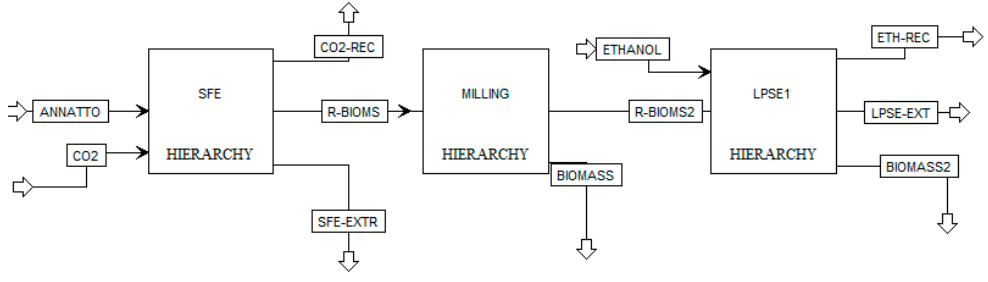
Figure A1. Overall annatto seeds biorefinery flowchart developed in Aspen Plus ® .